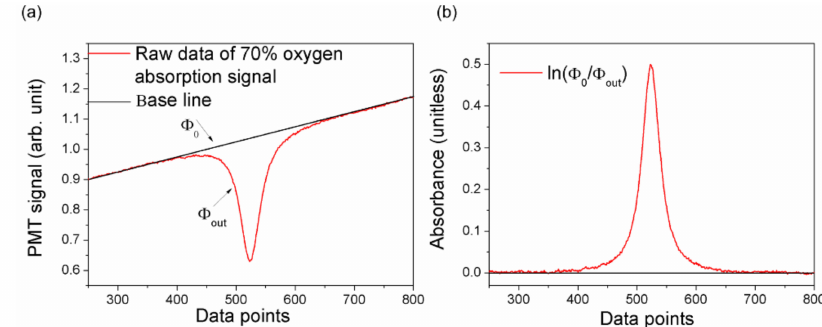
Figure 3. ( a ) Direct scan PMT (photomultiplier tube) signal for 70% oxygen concentration in the